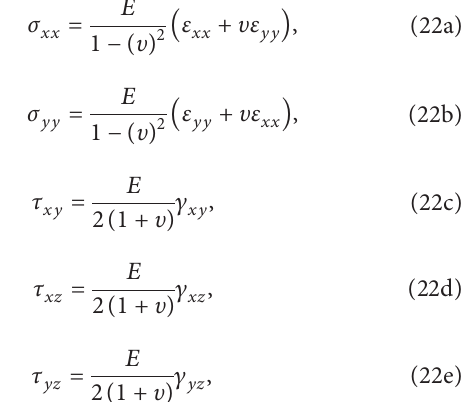
Figure 15: Comparison between the theoretical result and the ANSYS